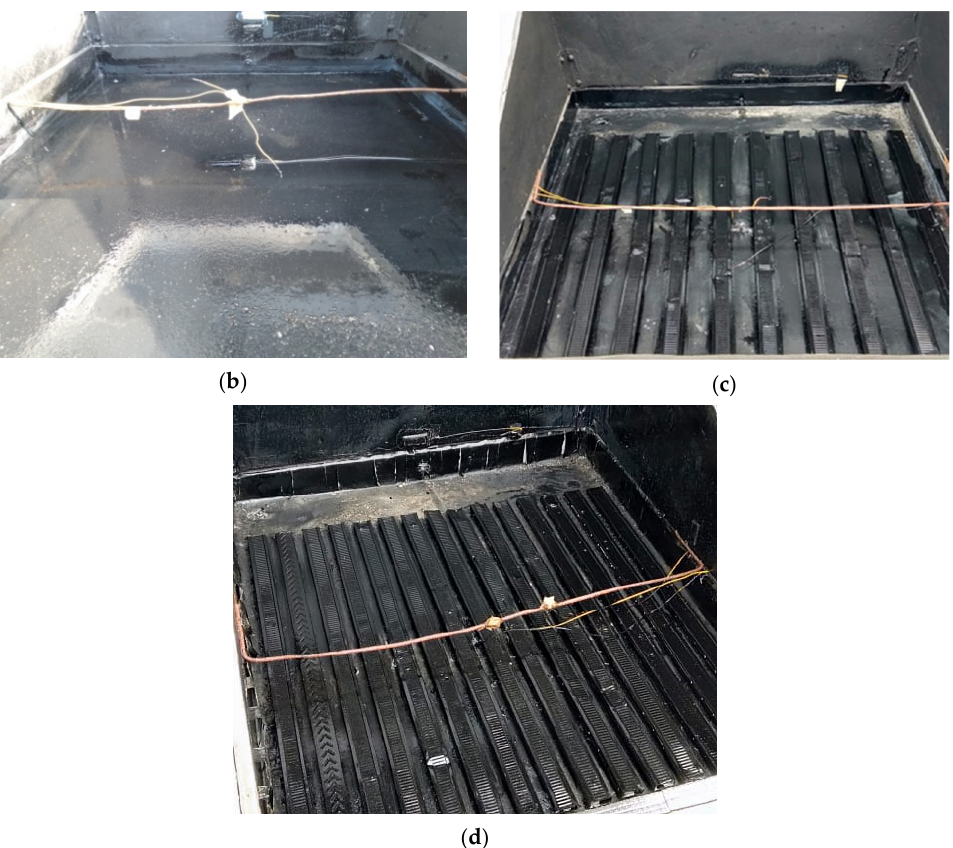
Figure 2. Absorbers used in this study: ( a ) geometry and schematic drawing of flat absorber and absorbers with 10 and 15 fins [1], ( b ) photograph of flat absorber for Case A, ( c ) photograph of absorber with 10 fins for Case B, and ( d ) photograph of absorber with 15 fins for Case B.